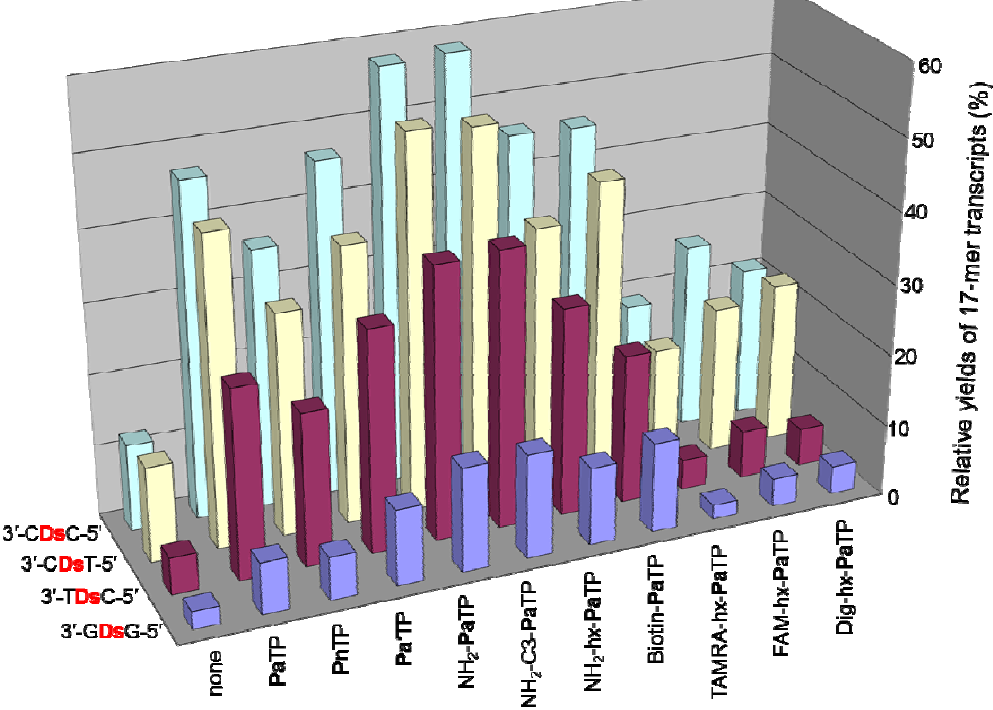
Figure 8. Plot of the relative yields of the 17-mer transcripts from templates with different sequences around Ds , with natural NTPs (1 mM), in the presence of each modified- Pa TP or Pn TP (1 mM). The relative yield of each full-length transcript was determined by comparison to the yield of the native transcript from the template consisting of the natural bases only (3 ′ -N Ds N -5 ′ = 3 ′ -CAT-5 ′ for ′ -C Ds C-5 ′ , 3 ′ -C Ds T-5 ′ , 3 ′ -T Ds C-5 ′ ; 3 ′ -N 1 2 for ′ -G Ds G-5 ′ ). The values were averaged from three to four data